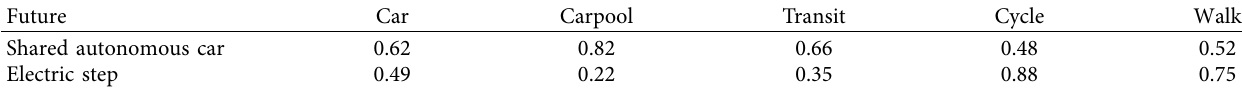
Table 9: Similarity index for each mode compared to the future mode.